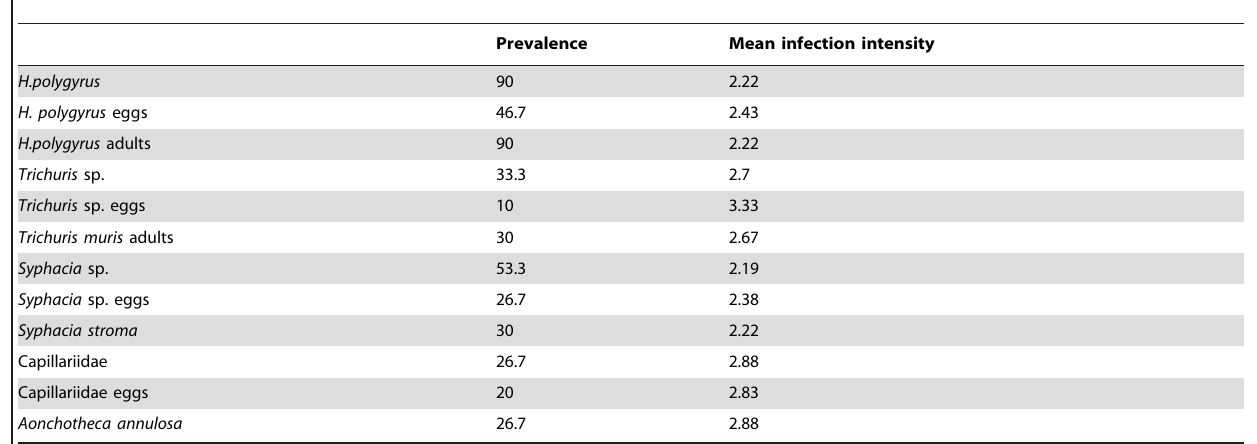
Table 1. Prevalence and mean infection intensity of detected gastrointestinal parasites in A. flavicollis .